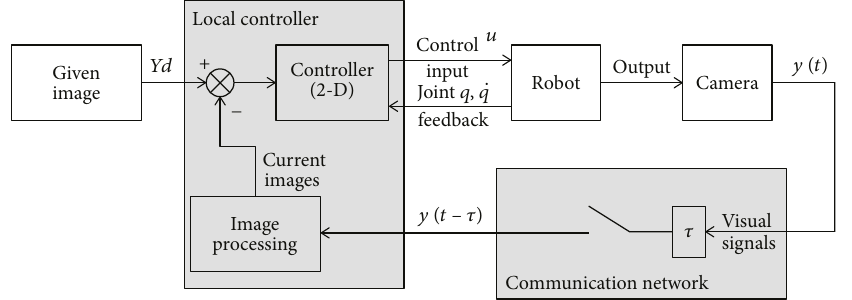
Figure 3: The structure of a delayed visual servoing robotic